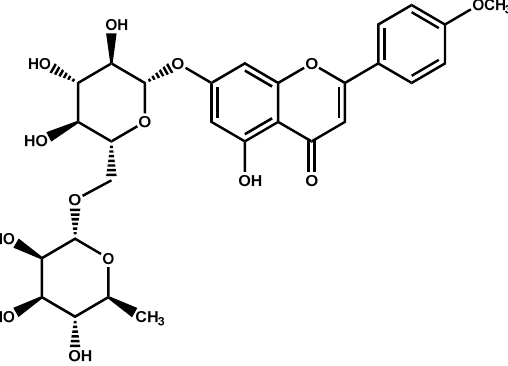
Figure 1. The chemical structure of linarin.